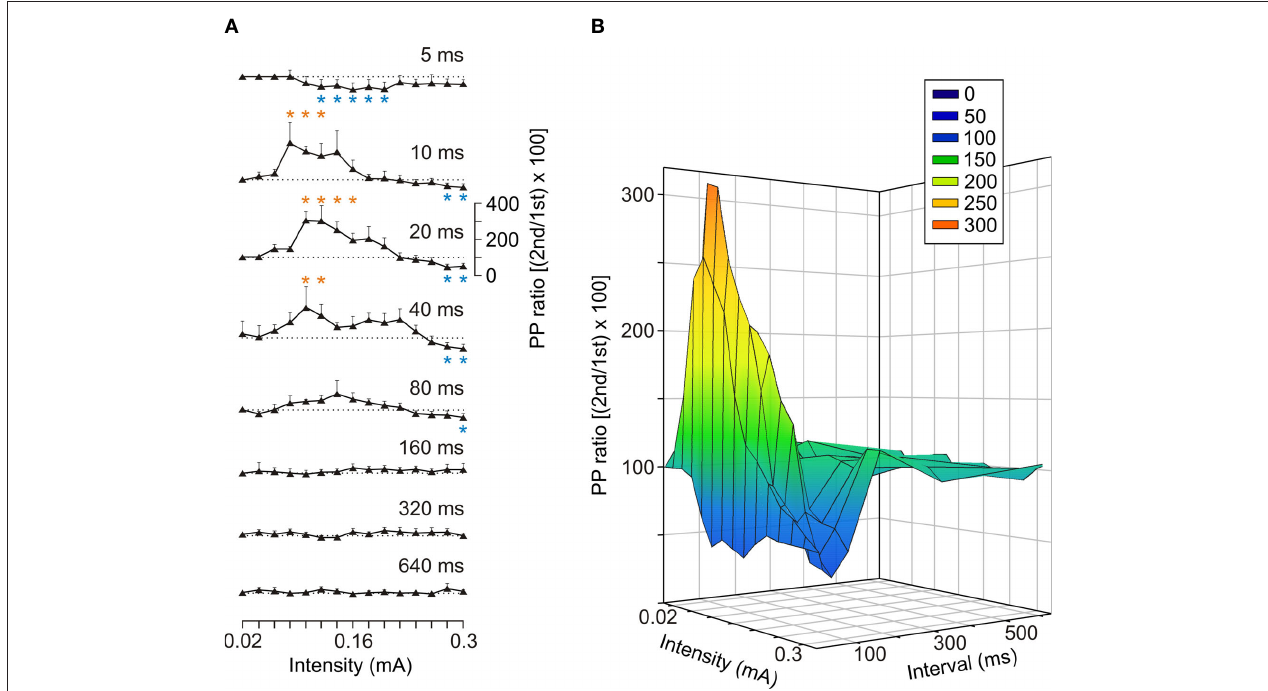
FIGURE 4 | Facilitation and depression evoked by paired-pulse stimulation of the CA3-CA1 synapse at different intensities and inter-pulse intervals. (A) Facilitation or depression of fEPSPs in the pyramidal CA1 area was evoked by pairs of pulses presented at the Schaffer collaterals, at the indicated intensities and inter-stimulus intervals. The paired-pulse ratio was calculated as